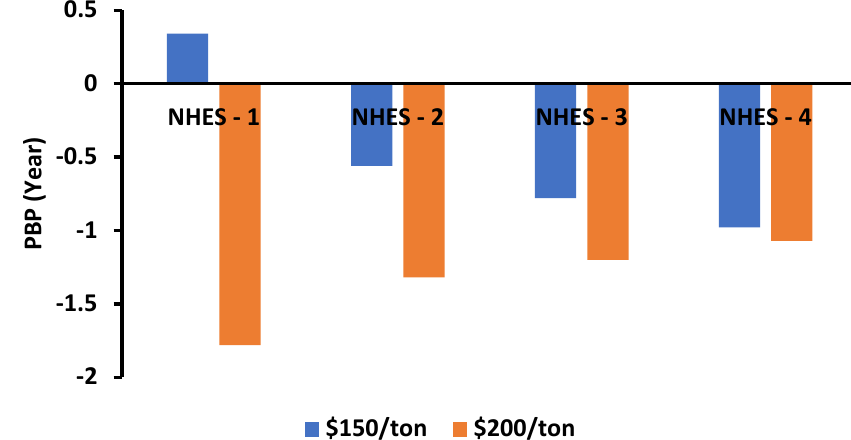
Figure 21. Difference in PBP based on increased carbon tax for Northwest region .